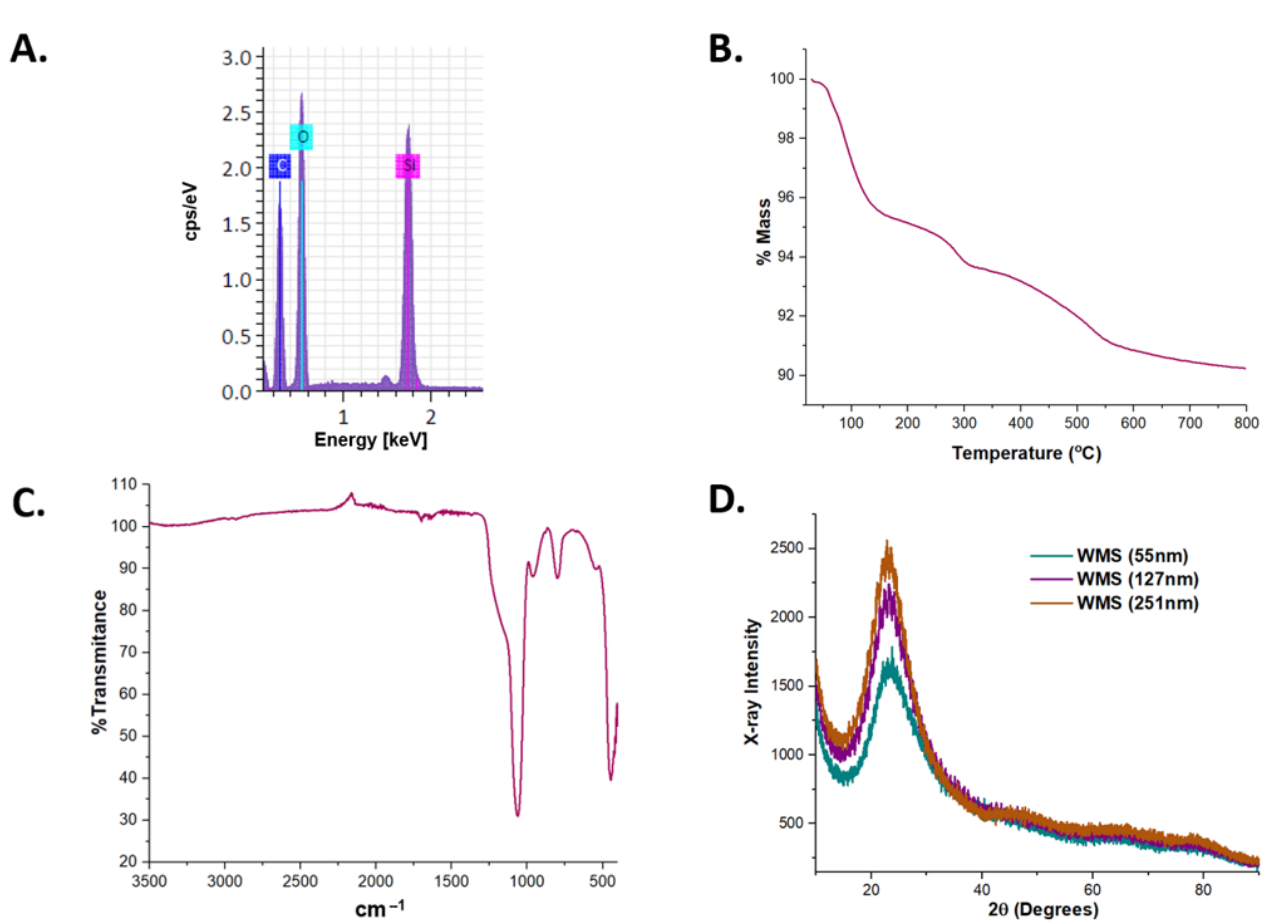
Figure 3. Typical characterization of WMS systems. ( A ) Chemical composition by EDS. ( B ) Thermal analysis by TGA in inert conditions. ( C ) FT-IR spectra. ( D ) Wide-angle XRD pattern.